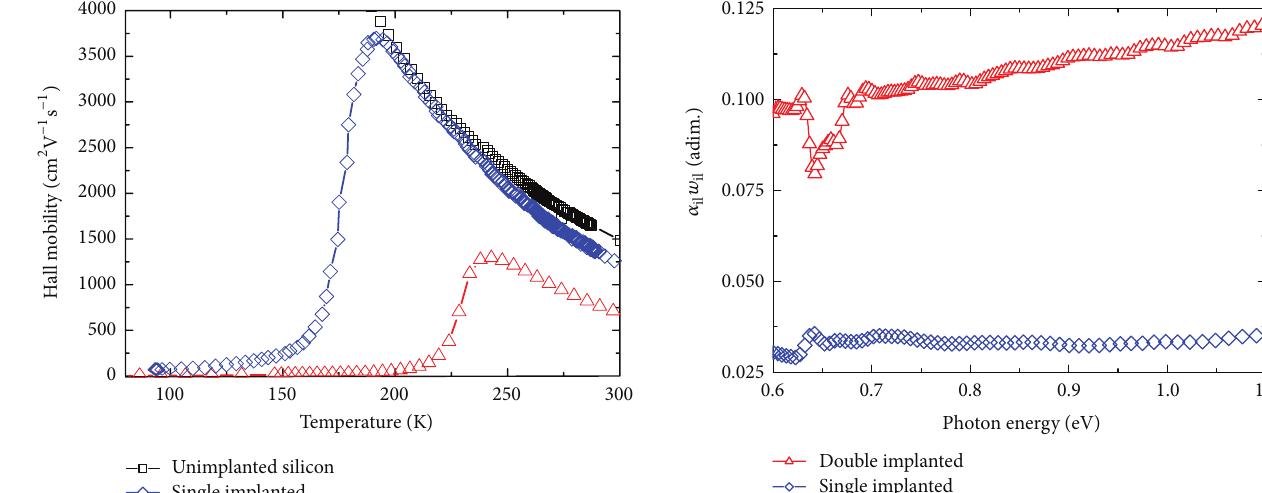
Figure 5: Hall mobility as a function of temperature measured for the single implanted and the double implanted samples. A Si reference substrate is used for comparison purposes.